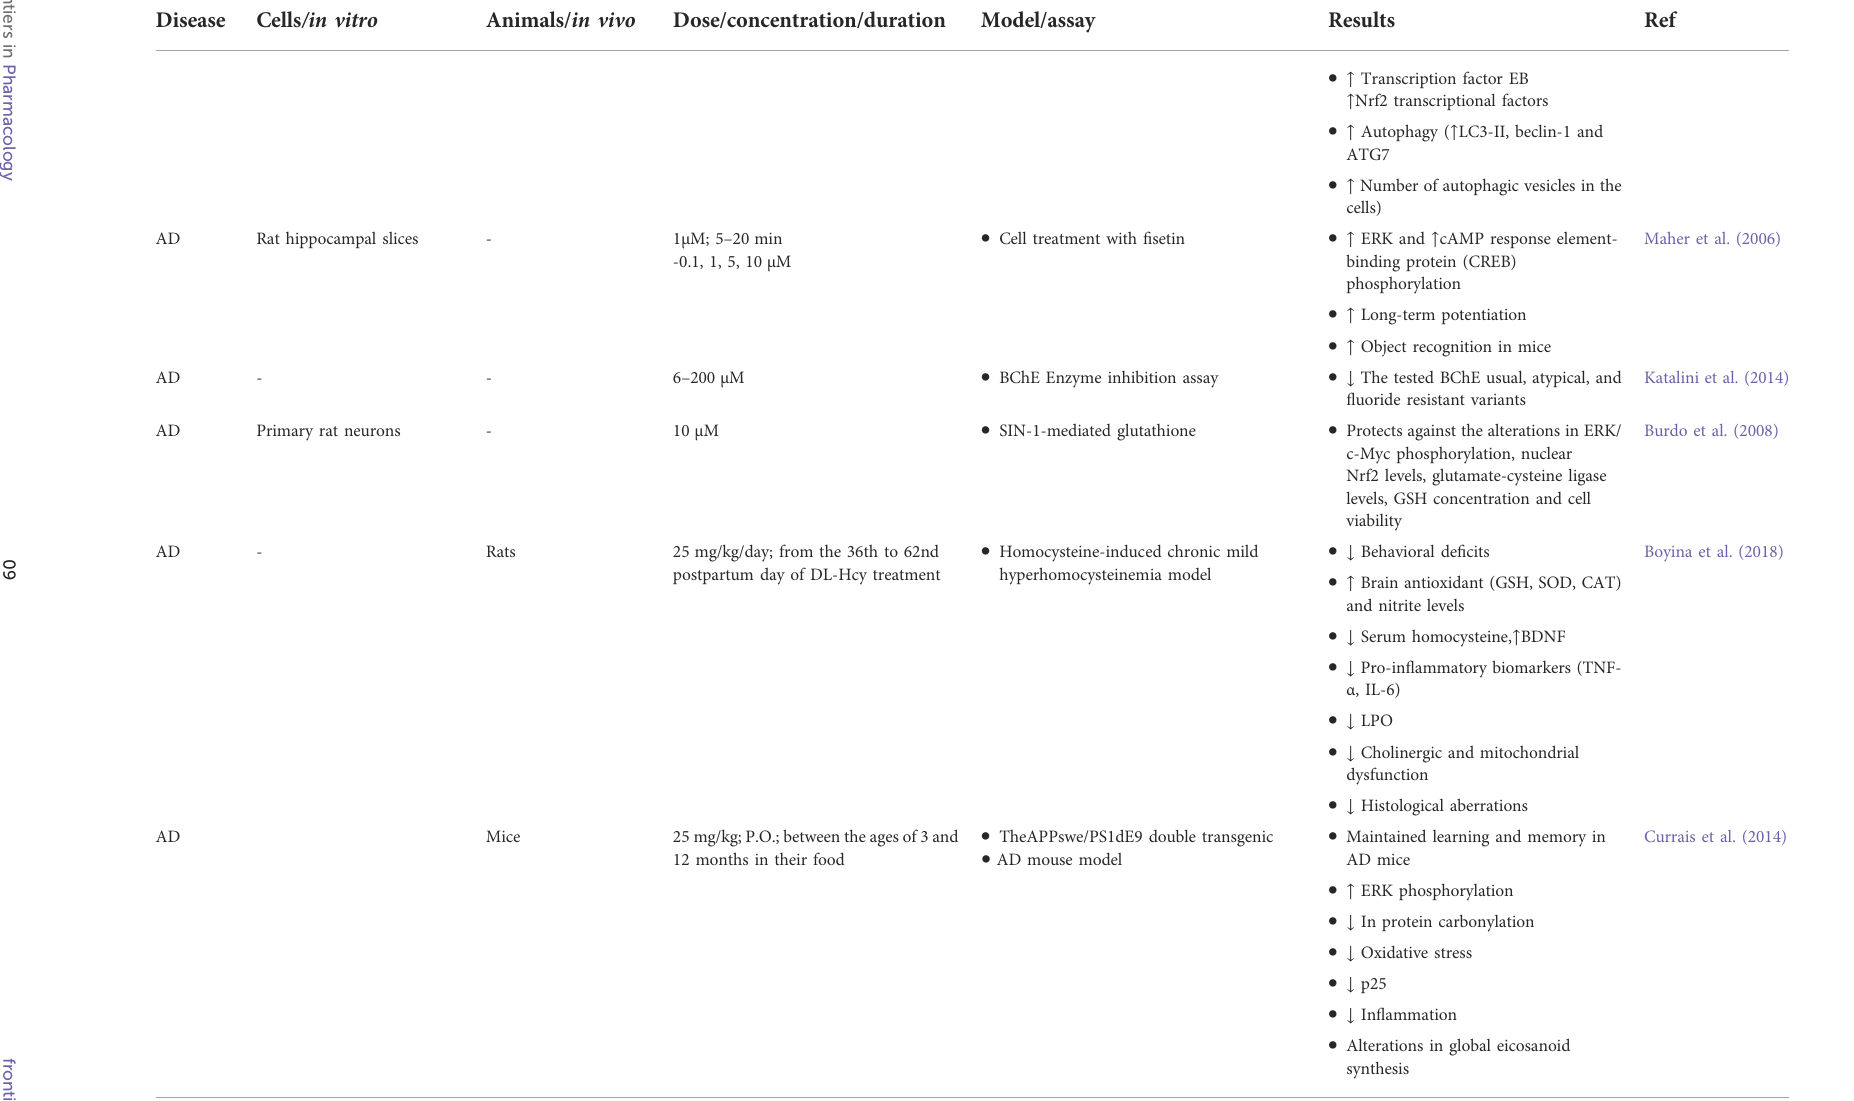
TABLE 1 ( Continued ) Different neurodegenerative disease and the protective role of fi